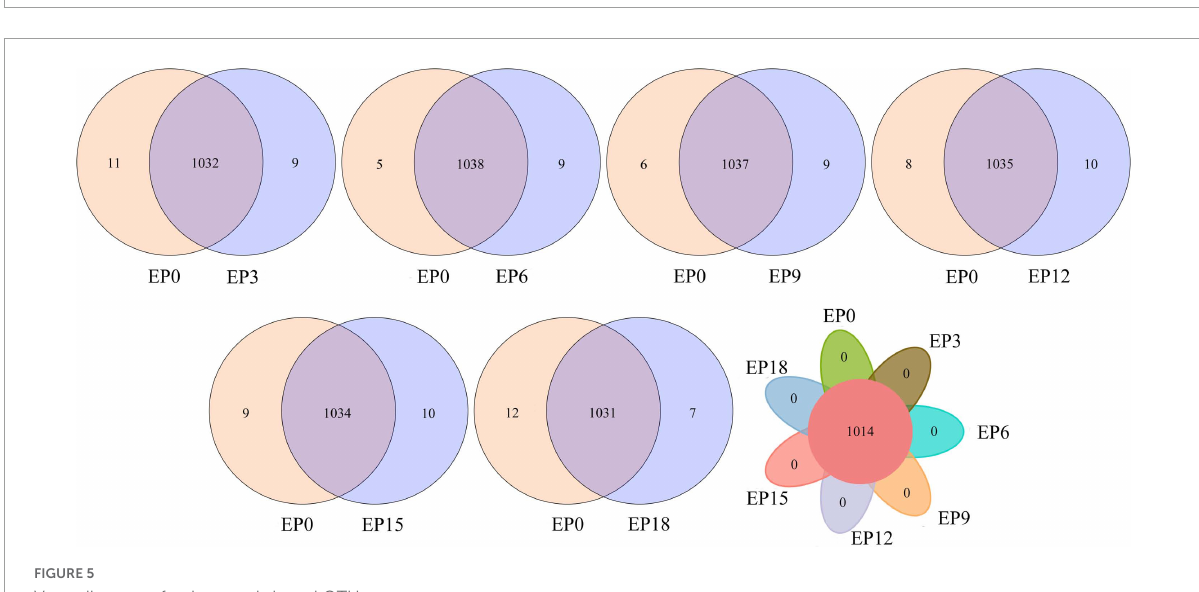
FIGURE5 Venn diagram of unique and shared